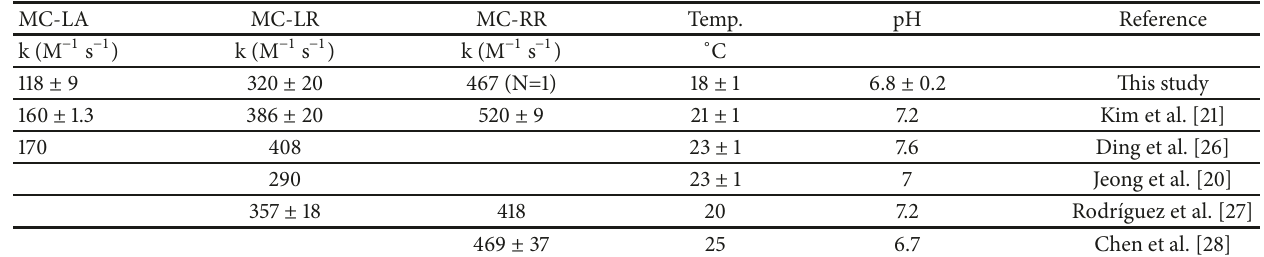
Table 1: Summary of second order rate constants for